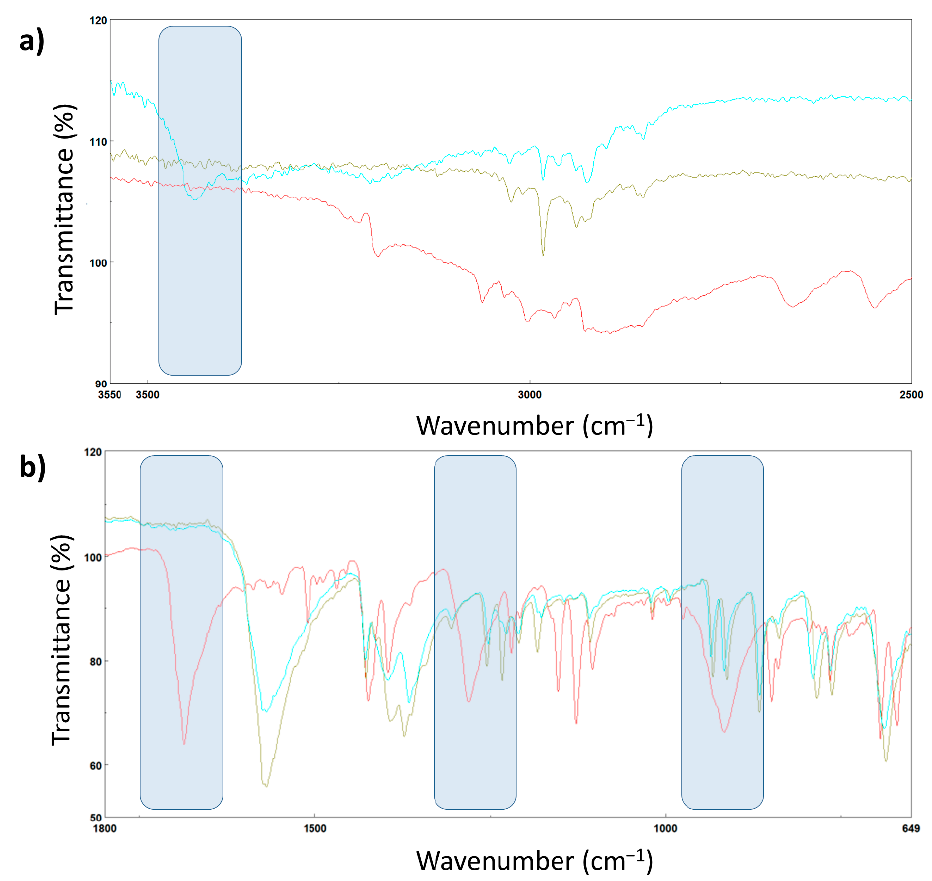
Figure 1. ( a ) ATR-FTIR spectra of 1P (cyan), 2H (green), and p -XBTA (red) in the 3500 − 2500 cm ⁻ 1 region. ( b ) ATR-FTIR spectra of 1H (cyan), 2H (green), and p -XBTA (red) in the 1800 − 650 cm ⁻ 1 region.